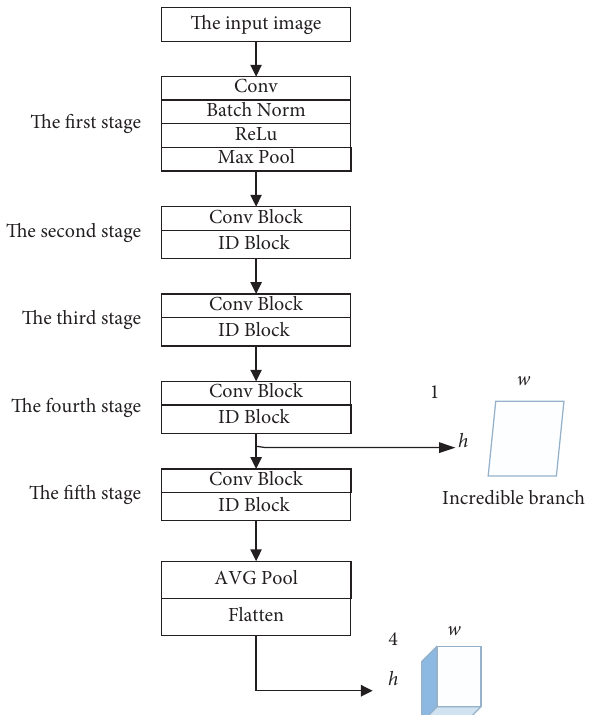
Figure 5: Confidence and prediction branches in deep residual